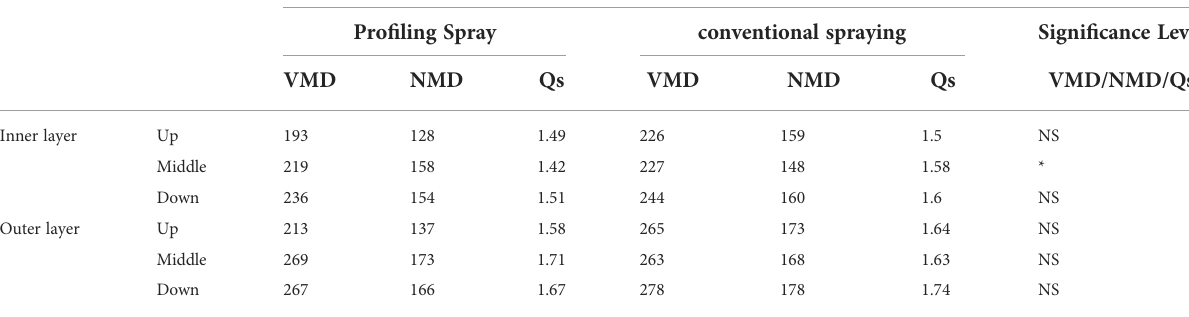
TABLE 4 Spray quality results of pro fi le variable spraying and conventional spraying. Zone of the